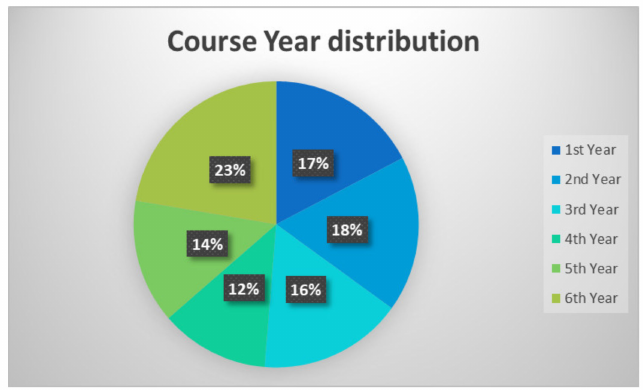
Figure 1. Years of the course of the responding students ( n = 301).